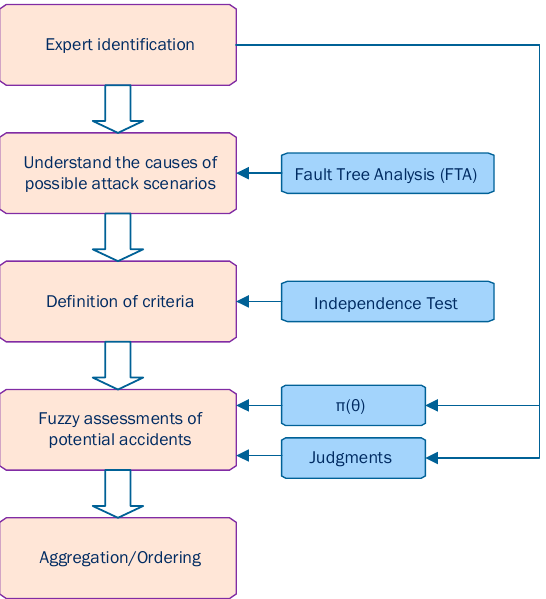
Figure 14. The five phases of the proposed cybersecurity risk analysis model using fuzzy logic and fault tree analysis [75]. Table 6. Procedure for FTA [75].